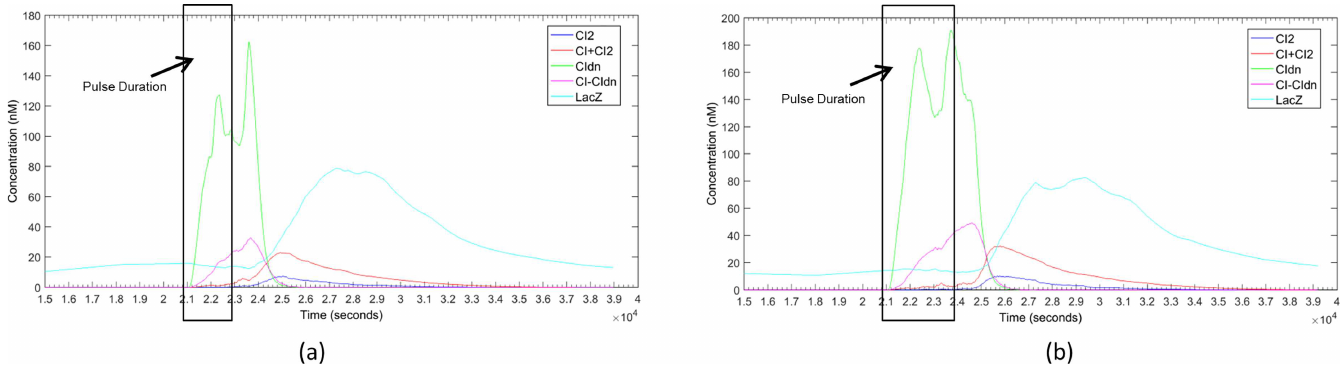
Fig 4. Response of the pulse detector circuit in Fig 1 for different pulse durations. The RBS1:RBS2 ratio was set to 20 and a deg-tag of 4 minutes was used. Each responsein the graph is the averageof 20 simulations. (a) The pulse was activated at 10.2 CC (20808sec) and deactivated at 11.2 CC (22848sec) [duration 1 bacterial cell-cycle(CC)]. (b) The pulse was activated at 10.2 CC (20808sec) and deactivatedat 11.7 CC (23868sec) [duration 1 ½